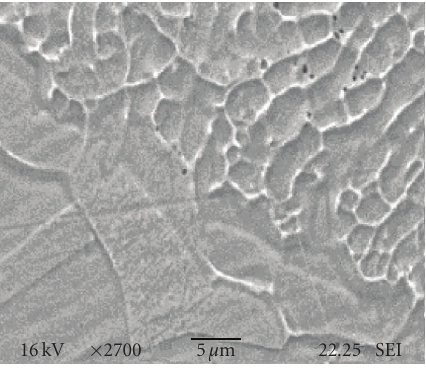
Figure 3: Details of transition area between welded